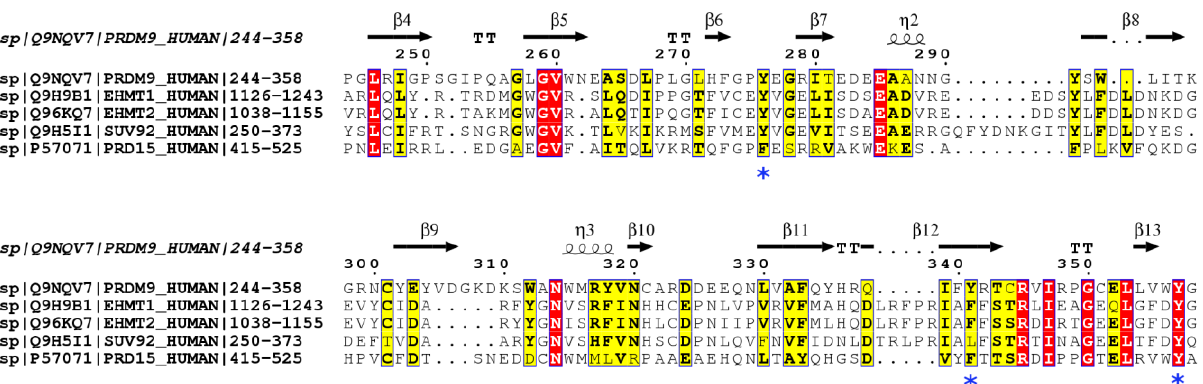
Figure 5. Sequence alignment of PRDM9, EHMT1 (GLP), EHMT2 (G9a), SUV92H2, and PRDM15. This figure was generated by ESPript 3.0. Note that the blue stars indicate the catalytically important residues.